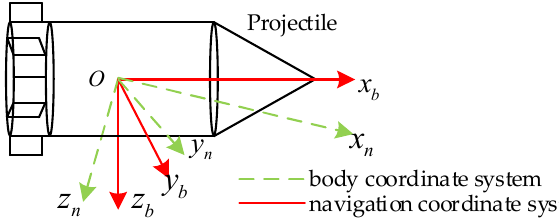
Figure 4. Definition of projectile attitude measurement coordinate system.